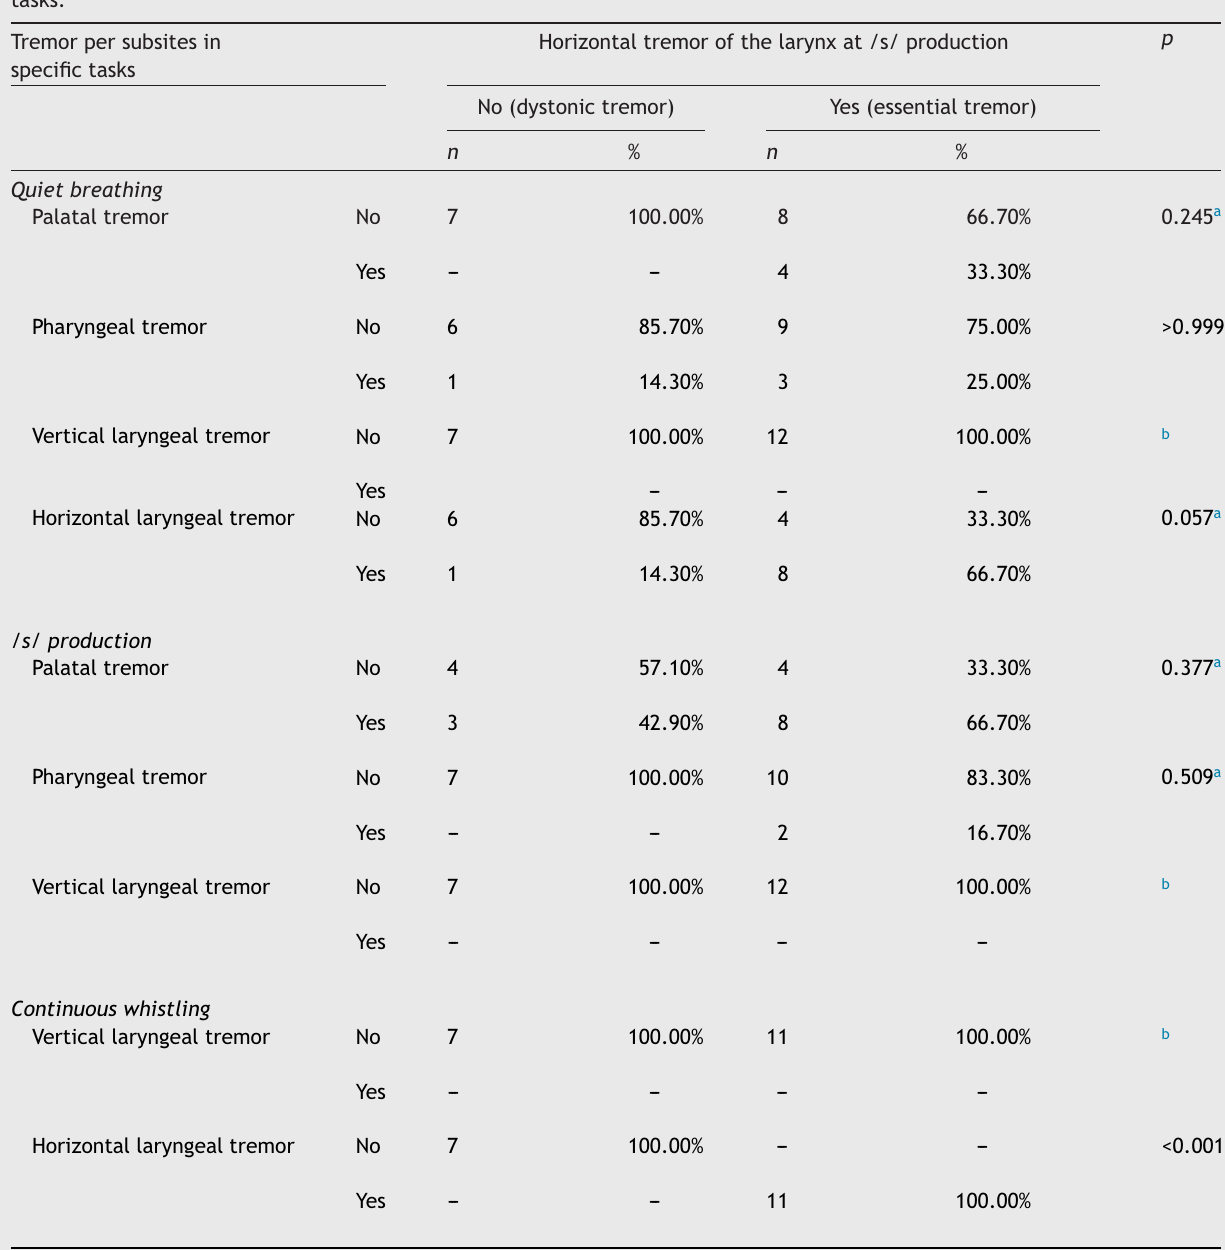
Association of the essential and dystonic tremor syndromes with the presence of tremor per subsites in non-phonatory tasks. Tremor per subsites in specific